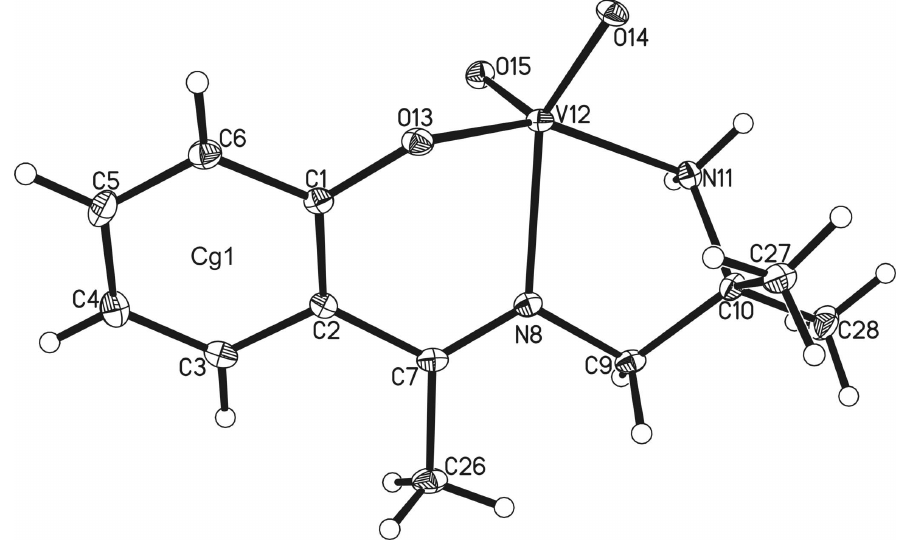
The molecular structure of the title complex (I), with displacement ellipsoids drawn at the 25% probability level and H atoms are shown as small spheres of arbitrary